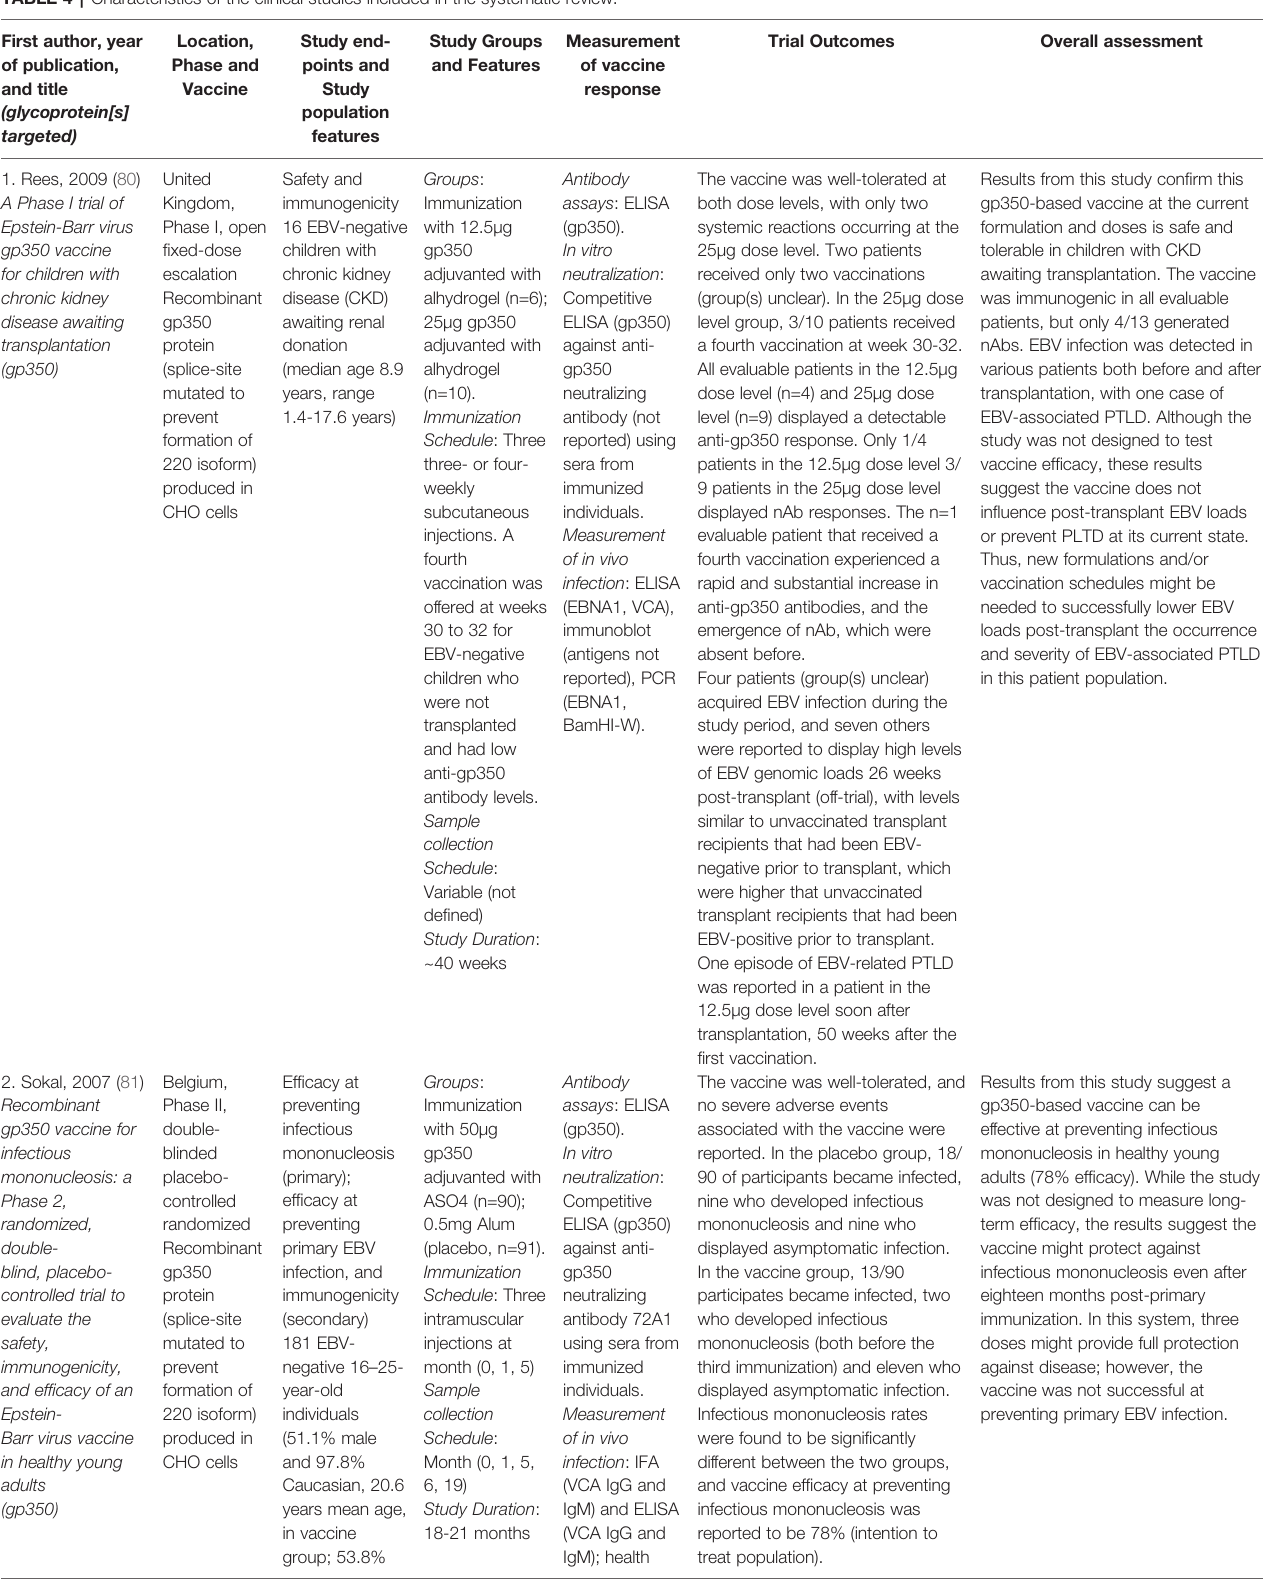
TABLE 4 | Characteristics of the clinical studies included in the systematic